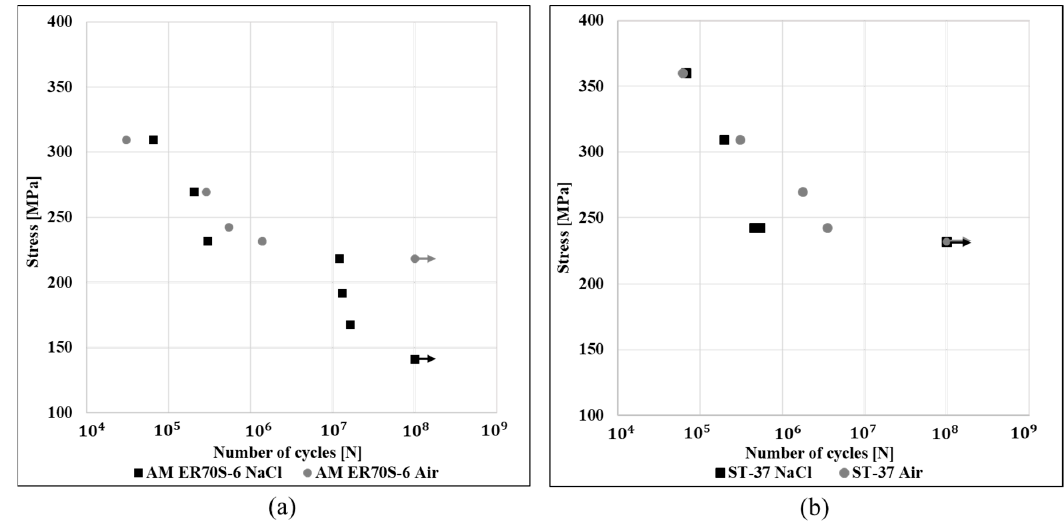
Figure 7. S–N curve obtained in air and in 3.5% NaCl solution for ( a ) additively manufactured ER70S-6 alloy and ( b ) counterpart ST-37 alloy.